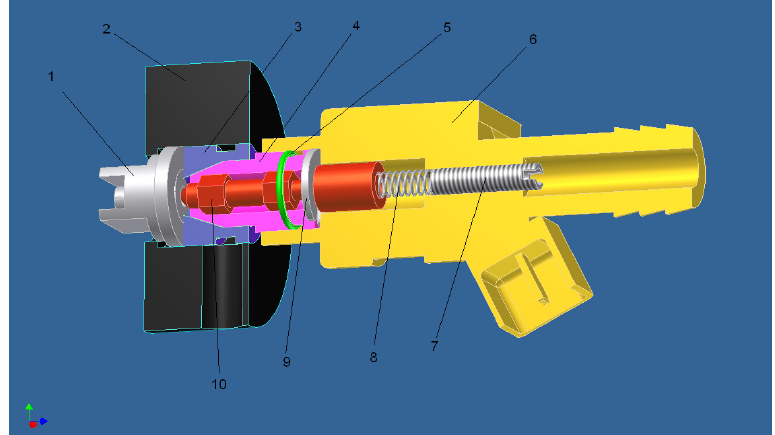
Figure 3. An electronically controlled sprayer valve, 1—body with coil, 2—nut fixing